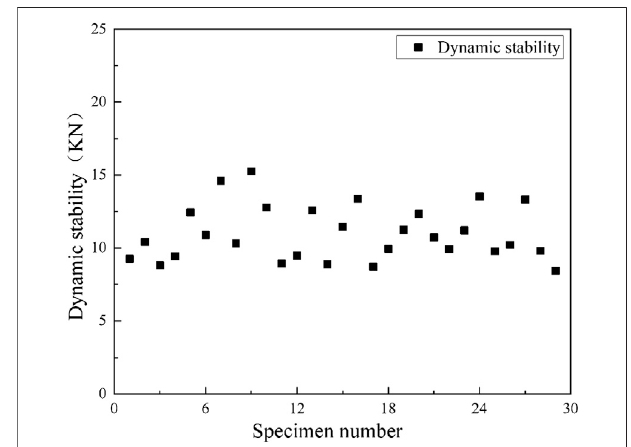
FIGURE 2 | Test results of dynamic stability of asphalt